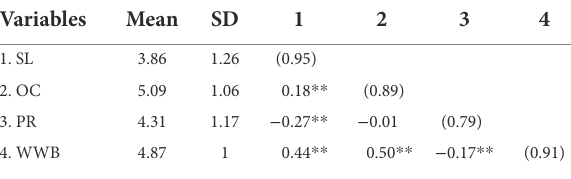
TABLE 1 Correlation coefficients of each variable and Cronbach’s α